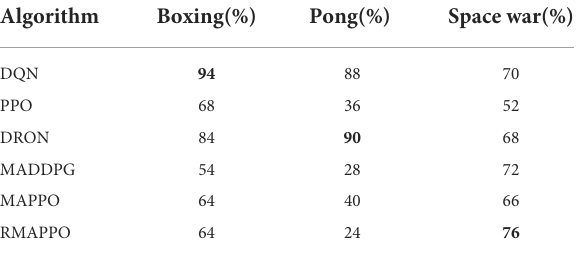
TABLE 2 Overall winrate percentage of various algorithms across Boxing, Pong and Space War environments.